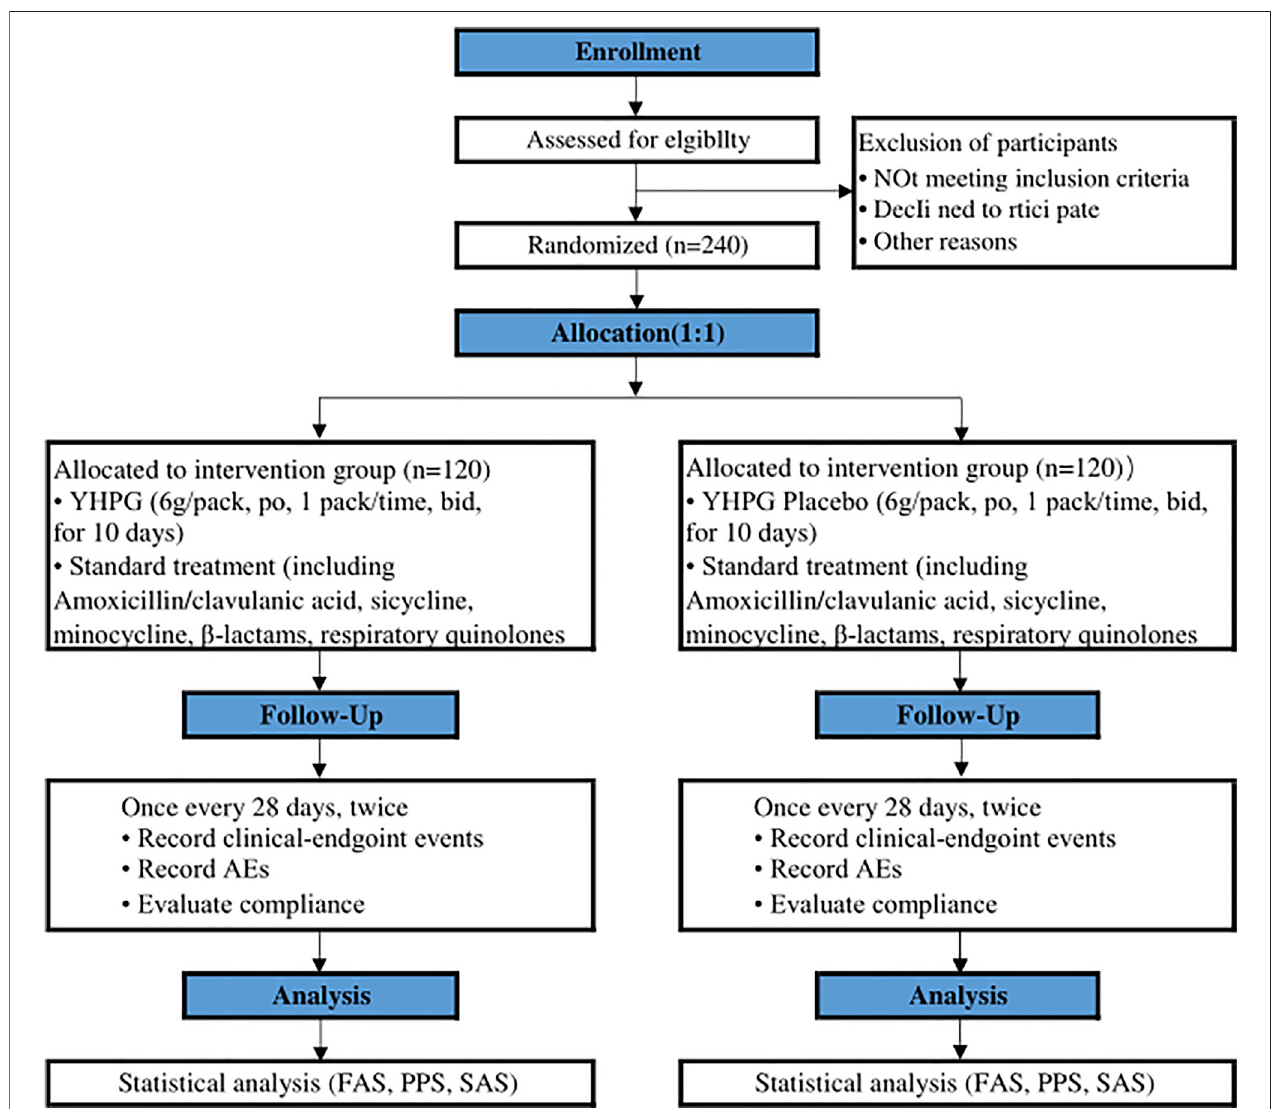
FIGURE1| Flowchartoftheclinicaltrialdesign.ThetemplateisfromtheCONSORT2010 fl owchart.YHPG,Yinhuapinggan;AEs,adverseevents;FAS,fullanalysis set; PPS, per protocol analysis; SAS, safety assessment set.